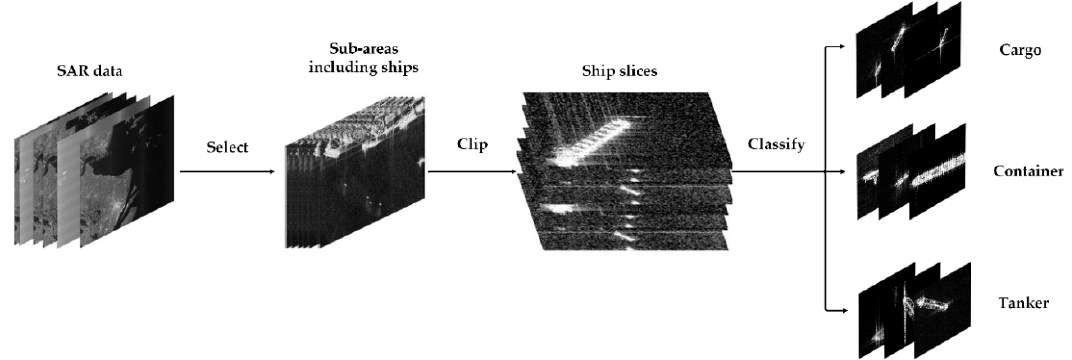
Table 1. Gaofen-3 (GF-3) high resolution ship slices.